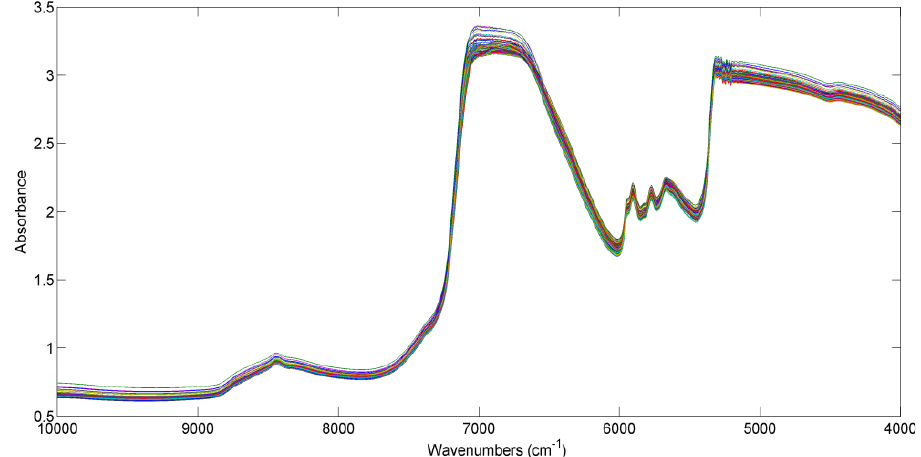
Fig. 1. The raw spectra of samples.